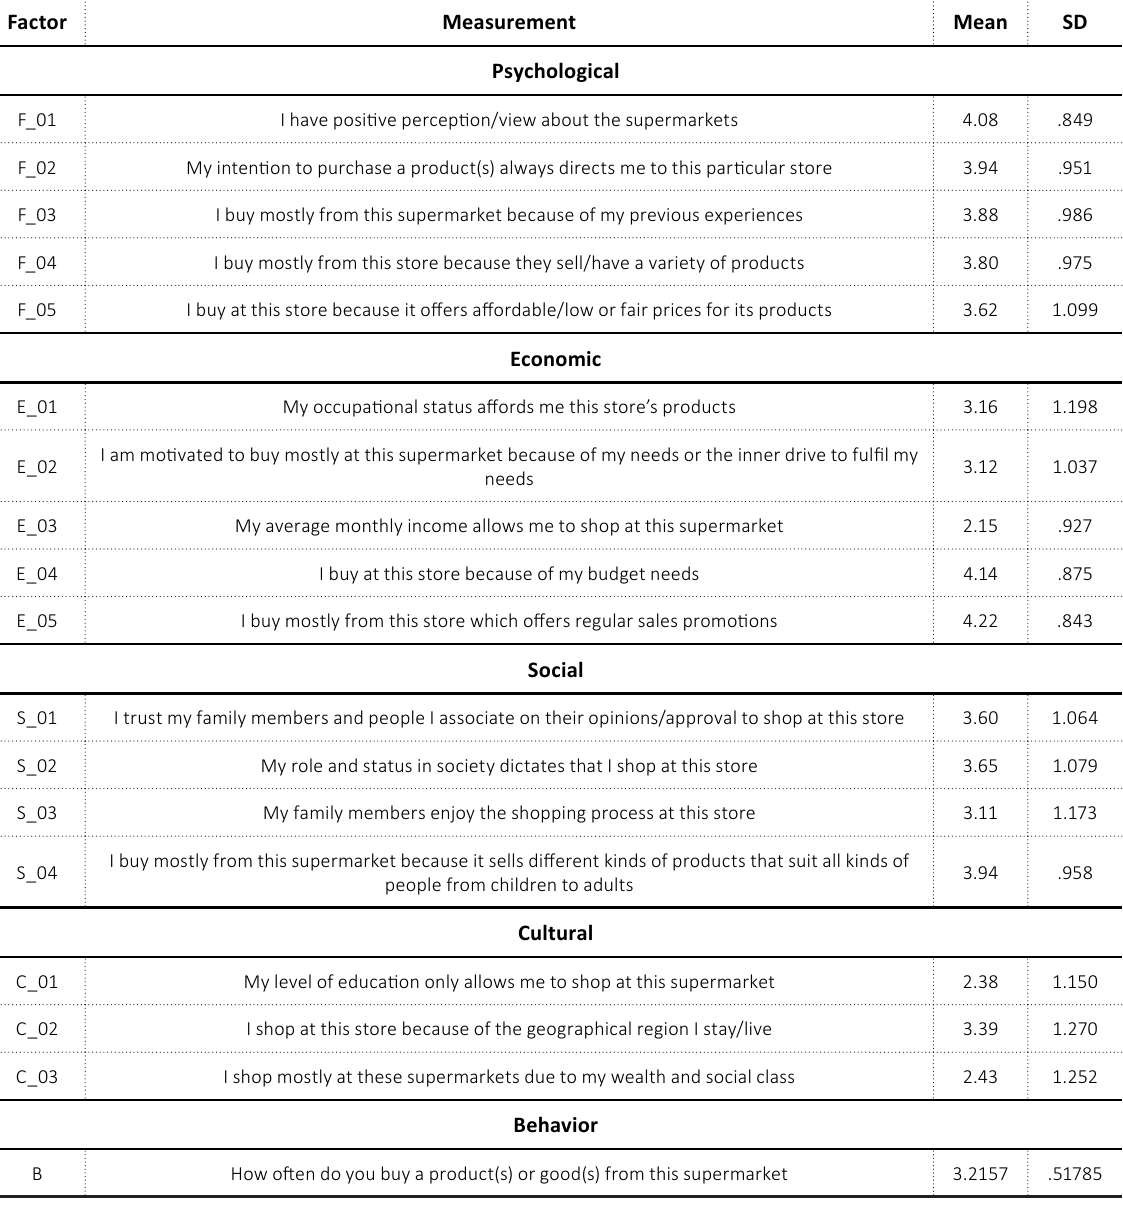
Table 3. Descriptive statistics of factors and their measurement